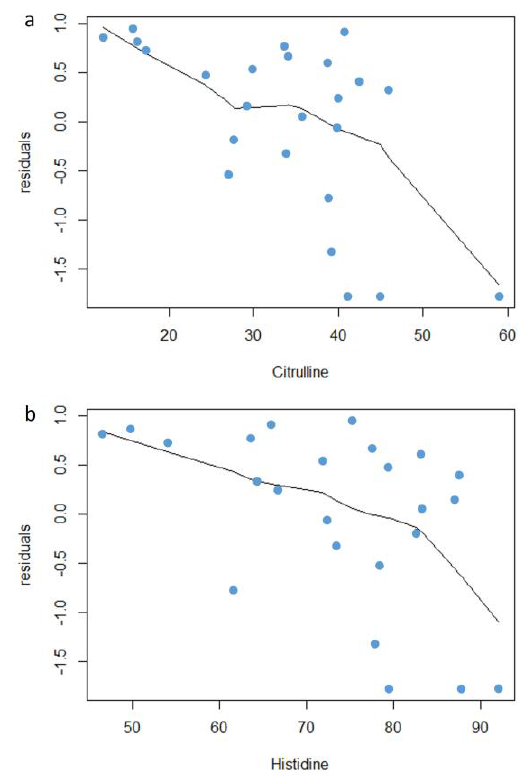
Figure 2. Scatter plot of the Martingale residuals for the metabolites citrulline ( a ) and histidine ( b ).